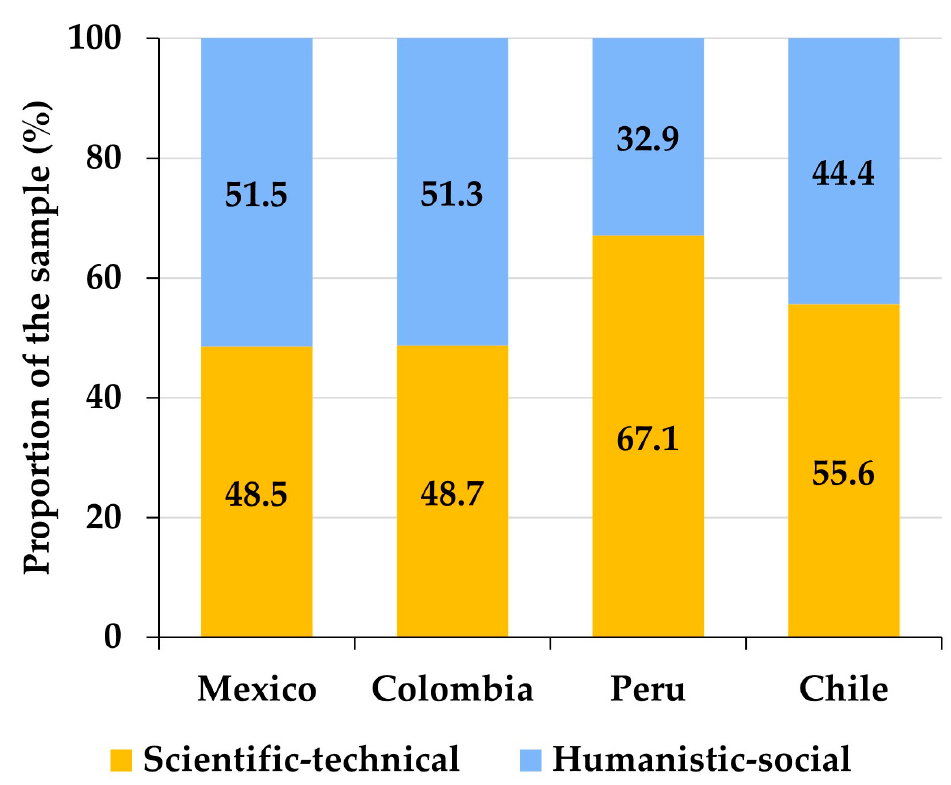
Figure 2. Distribution of participants by country of origin and knowledge area.